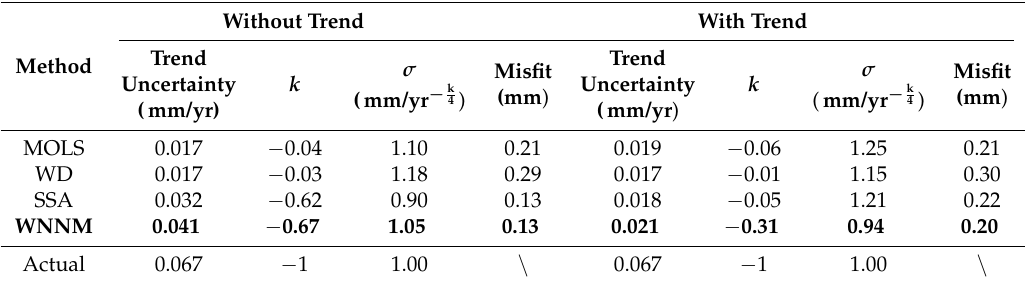
Figure 2. The power spectral density (PSD) of the original signal and residual time series estimated by different strategies, where σ f = 1 mm/yr − k 4 . The horizontal axis is frequency and the unit is cycle per year (cpy), and the vertical axis is power. The gray solid line represent the original time series, the black solid line is the synthetic noise and cyan, blue, yellow and red represents residuals estimated by applying MOLS, SSA, WD and WNNM, respectively. ( a ) Without trend and ( b ) with a linear trend. Table 1. Mean results of trend uncertainty, spectral index, noise amplitude and misfit estimated from 500 simulations under different strategies, where σ f = 1 mm/yr − k 4